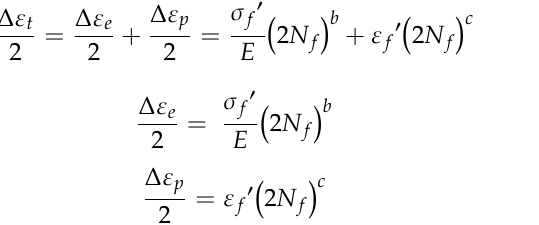
Table 4. LCF test results of the novel steel and 30SiMn2MoV steel.